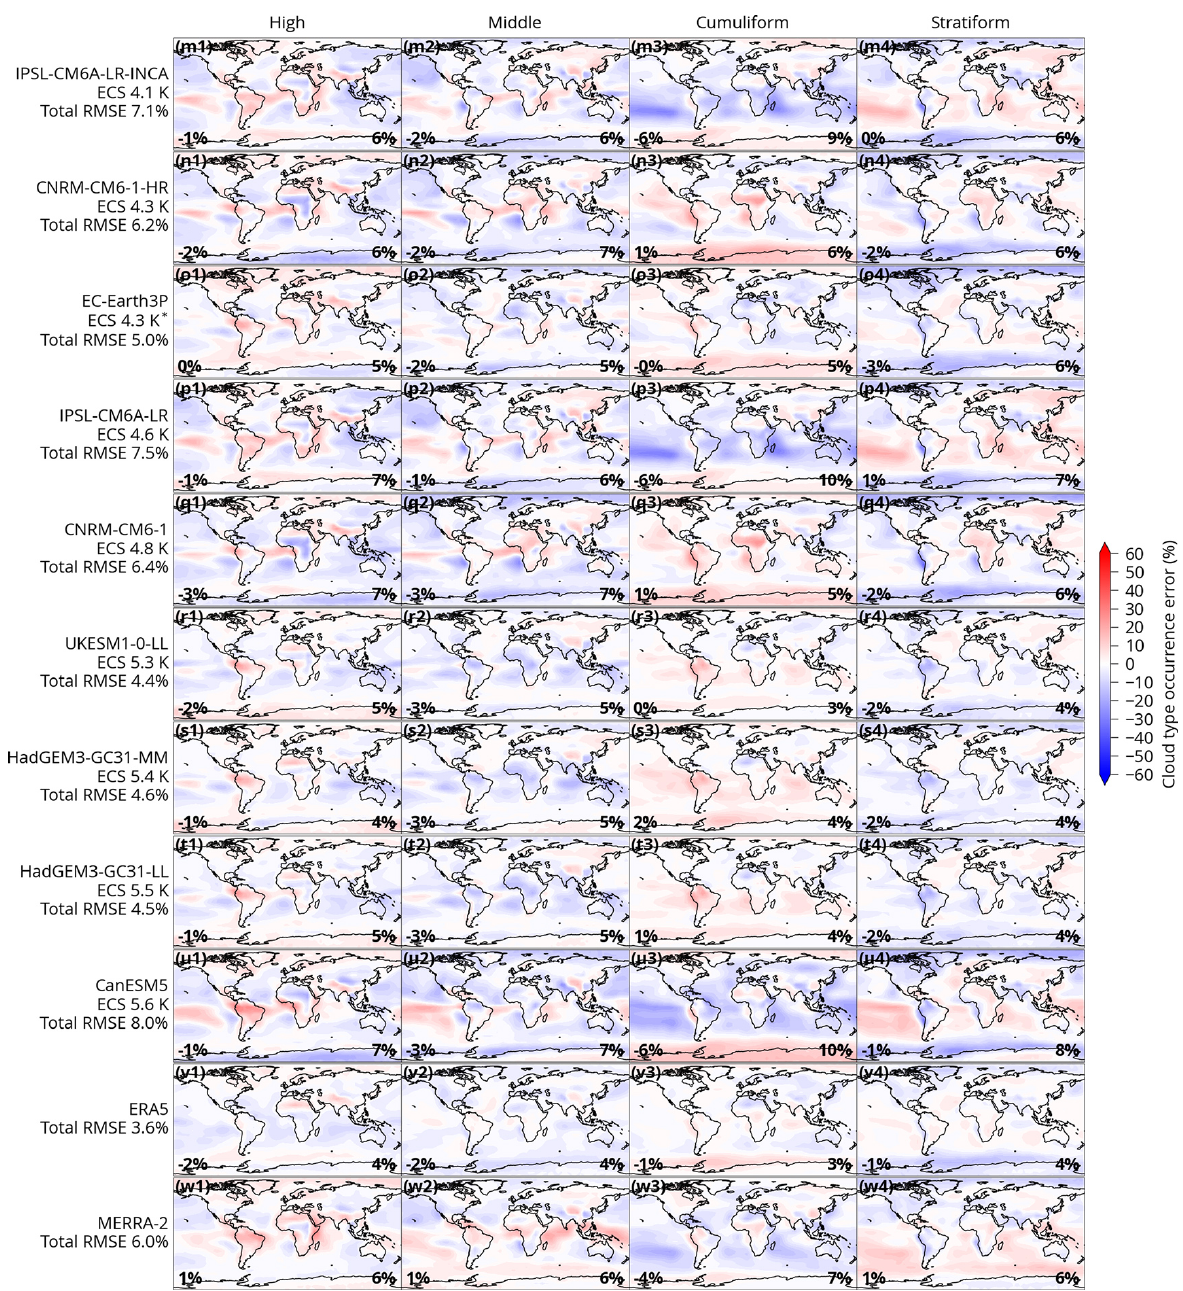
Figure 6. Geographical distribution of cloud type occurrence derived by applying the ANN to retrieved CERES satellite data in the years 2003–2020 (a1–a4) , directly from the IDD (year 2010) (b1–b4) , and by applying the ANN to model output of the historical experiment of CMIP6 and reanalyses in the years 2003–2014 relative to CERES (c–w) . In the lower centre of the CERES plots is the geographical mean occurrence of the cloud type. In the lower left is the mean error and in the lower right is the RMSE. Models are sorted by their ECS from lowest to highest. Coastline data come from the public domain Global Self-consistent, Hierarchical, High-resolution Geography Database (Wessel and Smith, 1996, 2017). For some models, marked by “*”, ECS was not available and was taken from a related available model (see Table